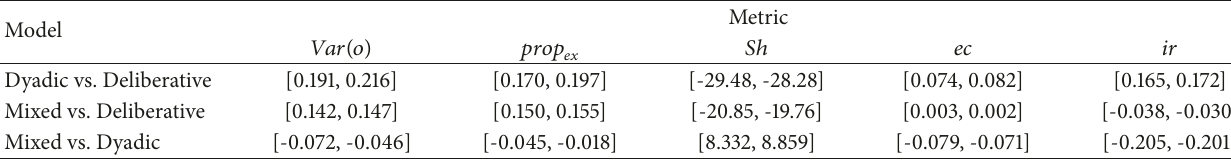
Table 5: Mean difference 0.95 confidence intervals for metrics by model